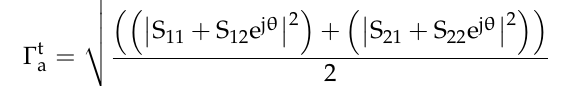
Figure 31. DG for the MIMO antenna in both modes.